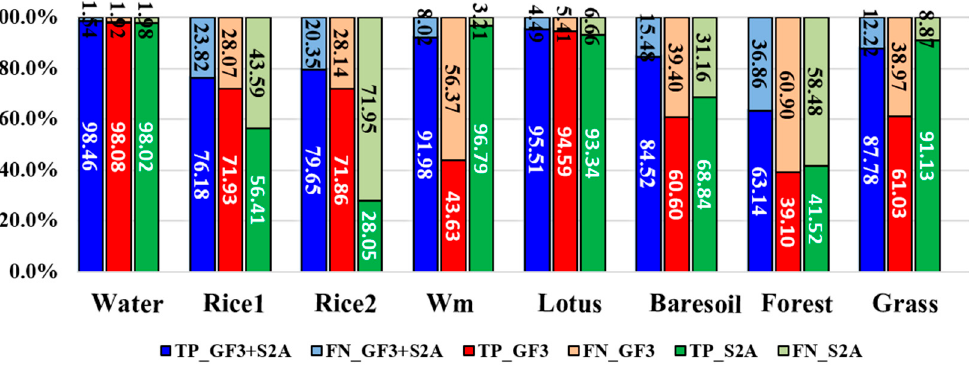
Figure 7. True positive (TP) rates and false negative (FN) rates of different land covers from different datasets. Wm means watermelon.